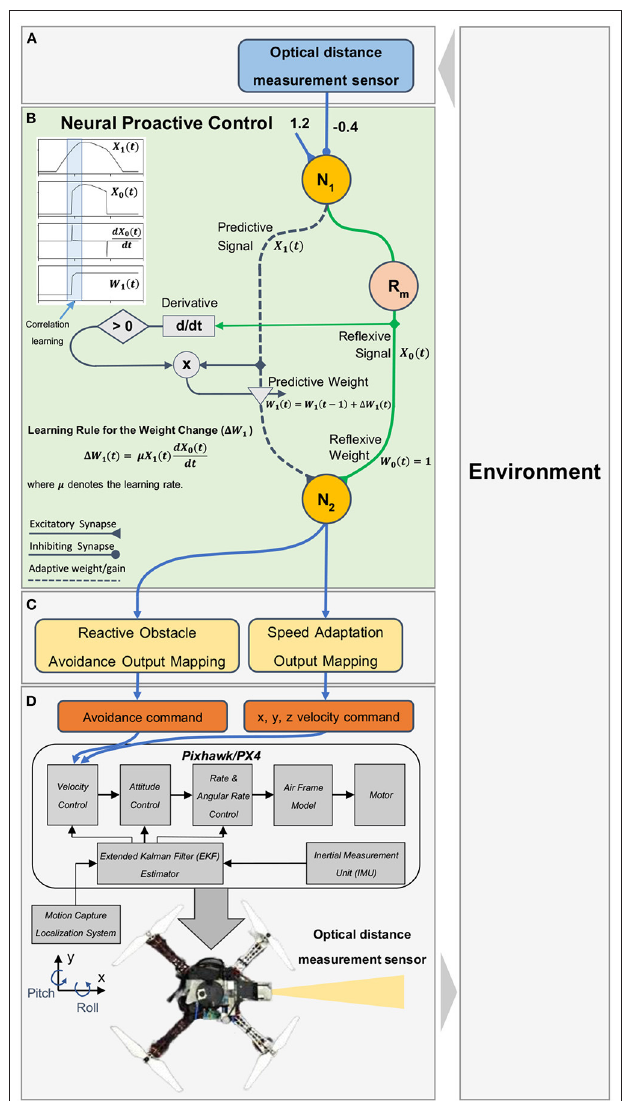
FIGURE 3 | Neural proactive closed-loop controller for speed adaptation and obstacle avoidance. The controller consists of four main modules: (A) the input module, using an optical distance sensor to detect the distance between a UAV and frontal obstacle; (B) the neural control module with the ICO learning mechanism as the main component of the proactive controller (the dark blue dashed line indicating the predictive path and the green line indicating the reflexive path), consisting of three neurons (two discrete-time non-spiking neurons (N 1 and N 2 ; see Equation 1) and one modified ReLU neuron (R m ; see Equation 2); (C) the output mapping module that maps the neural output to the low-level control by separating the output N 2 into speed adaptation control and obstacle avoidance control; (D) the flight controller (Pixhawk/PX4) for low-level control (i.e., velocity and attitude control). Note that the inset graph in (B) illustrates the predictive X 1 and reflexive X 0 signals, their correlation ( X 1 *dX 0 /dt) , and weight adaptation W 1 . In our implementation here, only the positive change of the reflexive signal is used for weight